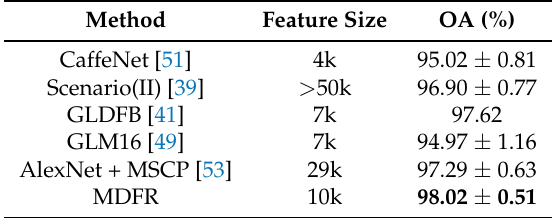
Table 5. Comparison of classification accuracy with other methods (UCM). The best result is in bold.